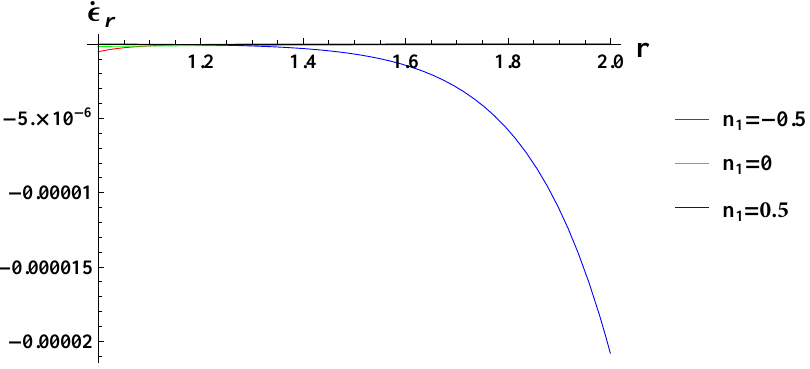
Figure 9. Radial strain rate along the radius r (in cm) of the cylinder, under the effect of rotation ( ω 2 = 50 rad/s), external pressure p o = 50 MPa and exponential volume reinforcement. Tangential strain rate under decreasing reinforcement profile from inner to outer radius ( n 1 = 0.5) as seen in Figure 10, is tensile and increases exponentially along the radius of the cylinder. It is noted that tangential strain rate under increasing reinforcement case n 1 = − 0.5 is higher in magnitude at inner radial points and decrease at the outer radial of the cylinder, whereas the opposite behavior in case n 1 = 0 reinforcement case is observed. In reinforcement cases n 1 = 0 and n 1 = − 0.5, tangential strain rate is again tensile and ceases towards the outer radial